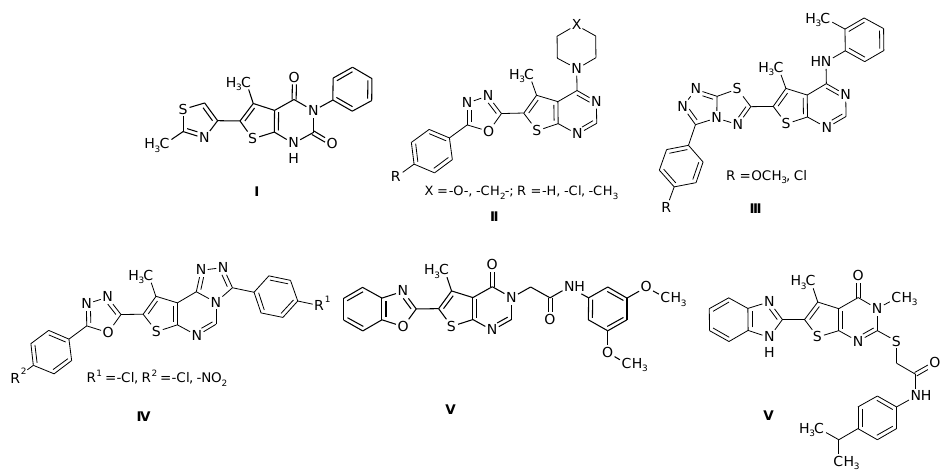
Figure 1. 6-Heteryl-5-methylthieno[2,3- d ]pyrimidines with antimicrobial properties. Several imidazo[1,2- a ]pyridine derivatives were reported as compounds with anti- microbial properties which may be useful against parasites of the Leishmania genus (VII) (Figure 2) [9]; this heterocyclic system is the core structure of savolitinib [10], a mes- enchymal epithelial transition factor (MET) inhibitor recently approved in China after the results of a pivotal phase II trial in patients with NSCLC/pulmonary sarcomatoid carcinoma [11]. This fragment is also a part of the innovative drug olprinone, which is a selective phosphodiesterase 3 (PDE3) inhibitor [12]. Imidazo[1,2- a ]pyridines were also reported as antiproliferative agents [13], α -glucosidase inhibitors [14] and antimicrobials (VIII) (Figure 2) [15]; some of these compounds have shown promising antibacterial activity against S. pyogenes , P. aeruginosa and S. aureus (IX) (Figure 2) [16].